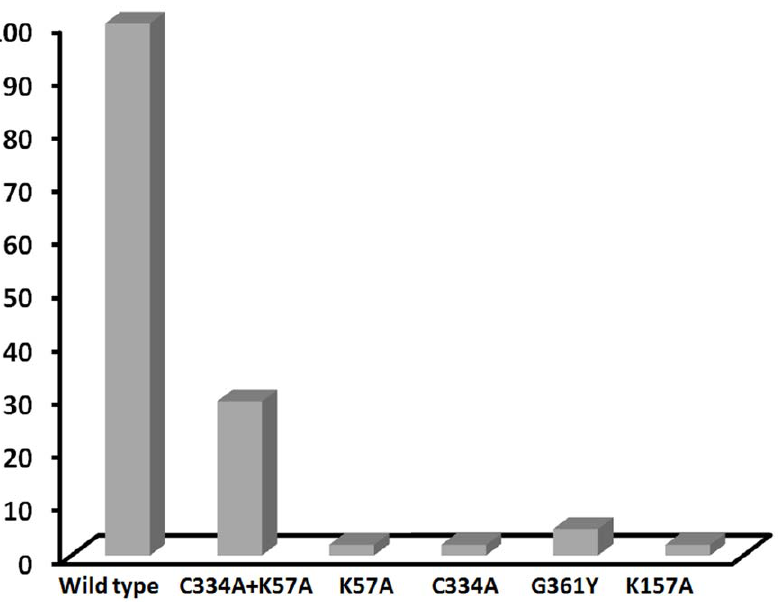
Figure 10. Enzyme activity of wild type Eh ODC and its mutants. Enzymatic activity of Eh ODC mutants relative to the activity of the wild-type enzyme. Cys334Ala, Lys57Ala Gly361Tyr and Lys157Ala are inactive. Cys334Ala and Lys57Ala mutants were mixed in 1:1 ratio and the mixture shows recovery of approximately 29% of the wild-type enzyme activity. The plot represents the average of three measurements.